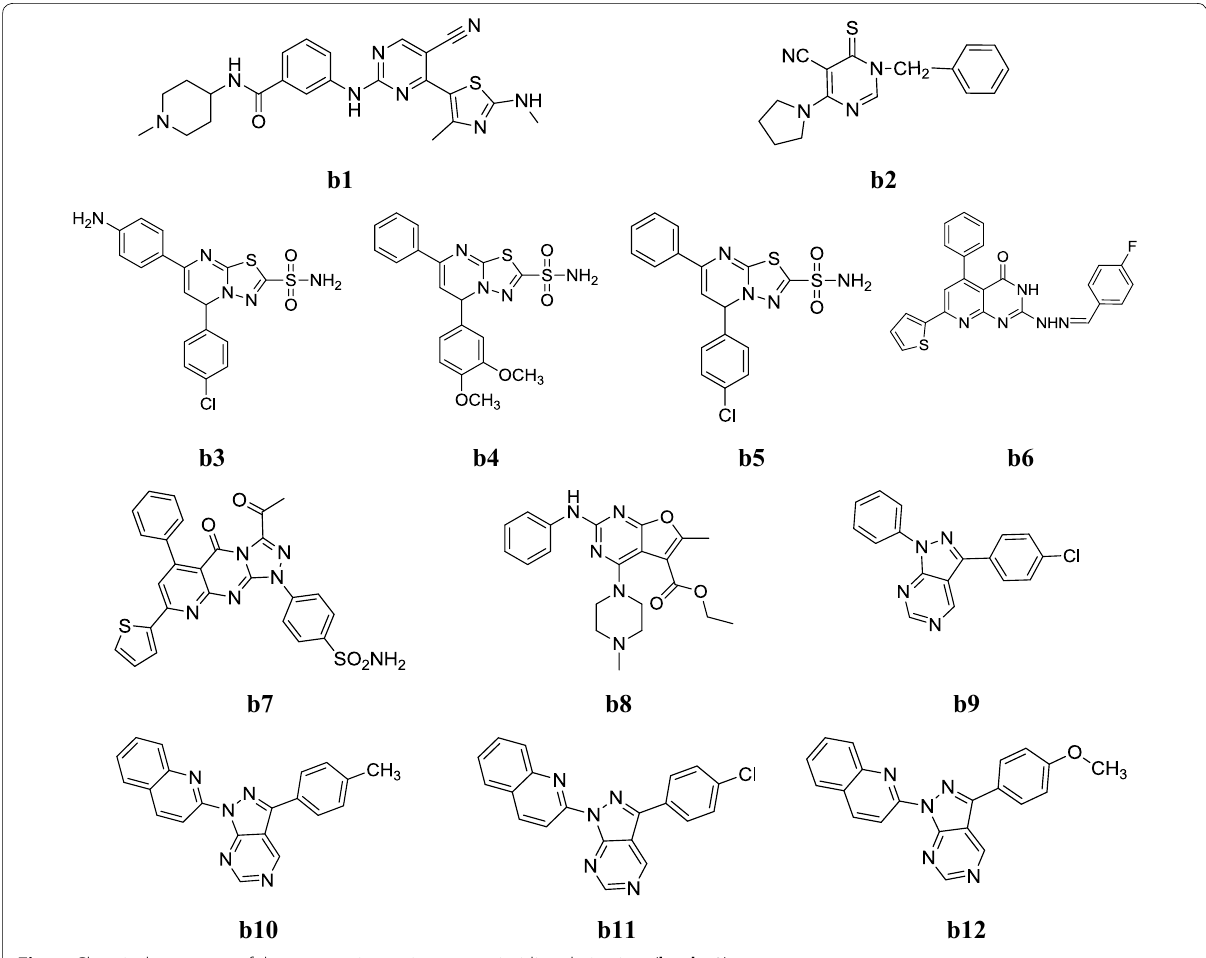
Fig. 5 Chemical structures of the most active anticancer pyrimidine derivatives ( b1 – b12